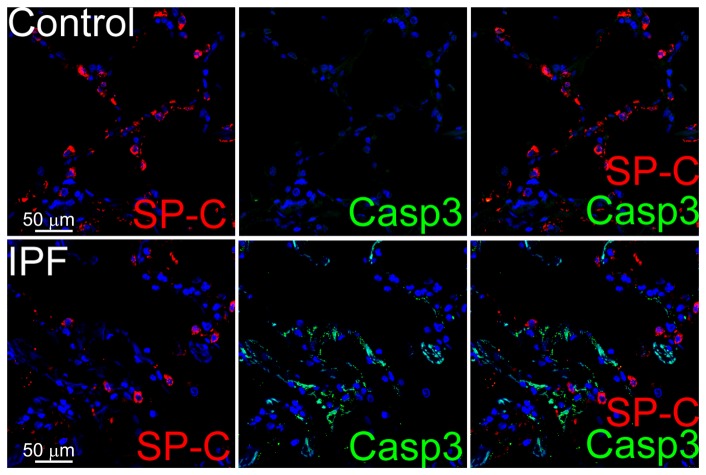
The lack of MMP-8 staining in type II alveolar epithelial cells in IPF lungs is not due to increased rates of apoptosis of these cells.Lung sections from a control and IPF patient were stained with a red fluorophore for a marker of type II alveolar epithelial cells (SP-C, left column) and with a green fluorophore for active caspase-3 (Casp3; middle column as a marker of apoptotic cells). Merged images (right) show apoptotic cells (stained green) in an area of severe fibrosis in the IPF lung, but these apoptotic cells are not ATII cells as assessed by the lack of co-localization of active caspase-3 and SP-C staining. There is no apoptosis in alveolar epithelial cells in the control lung, as expected. The images are representative of immuno-stained lung sections from 2 control subjects and 3 patients with IPF. Magnification is X 600.